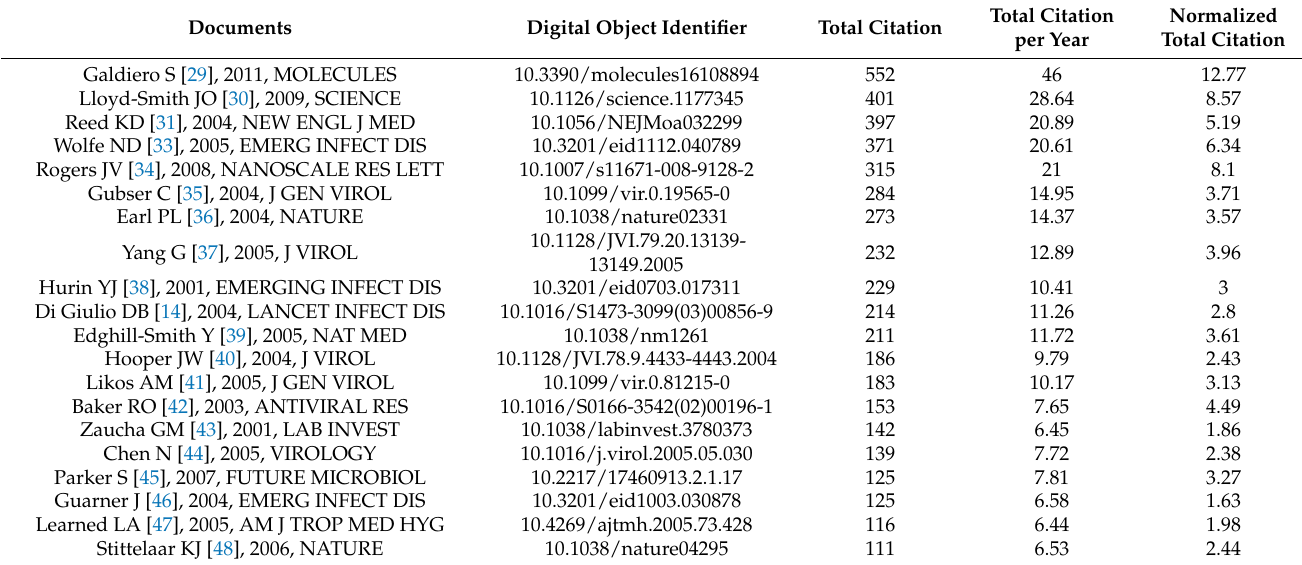
Table 3. The top 20 articles that were mentioned the most on a global scale.